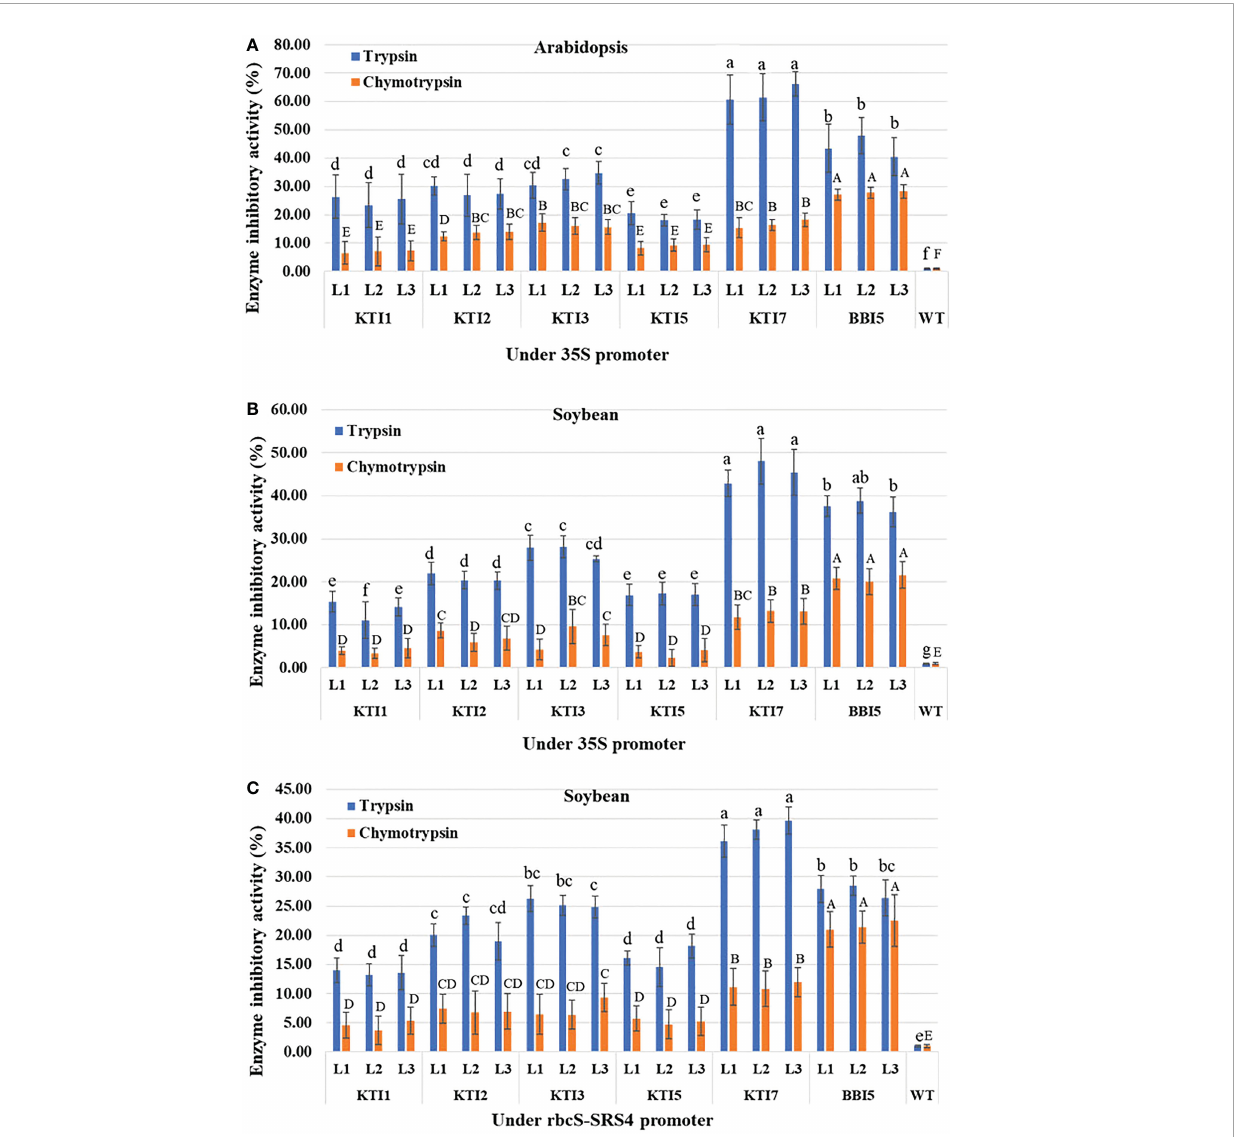
FIGURE 3 Enzyme inhibitory activity of the individual trypsin inhibitor gene (KTI1, KTI2, KTI3, KTI5, KTI7, BBI5) construct in leaves of six-week-old T 3 transgenic (A) Arabidopsis plants under the control of 35S CaMV promoter, (B) Soybean plants under the control of 35S CaMV promoter, and (C) Soybean plants under the control of rbcS-SRS4 promoter. Percentage of trypsin and chymotrypsin inhibition activities in leaf total protein extract from transgenic plants with corresponding each type of gene relative to that of non-transgenic wild-type plants. Bars represent mean values of six biological replicates (plants) per each independent line (L1, L2, L3) ± standard error. Bars with different letters are signi fi cantly different at p < 0.05 as tested by one-way analysis of variance followed by a Fisher ’ s least signi fi cant difference. Bars with lowercase letters represent trypsin group and uppercase letters represent chymotrypsin